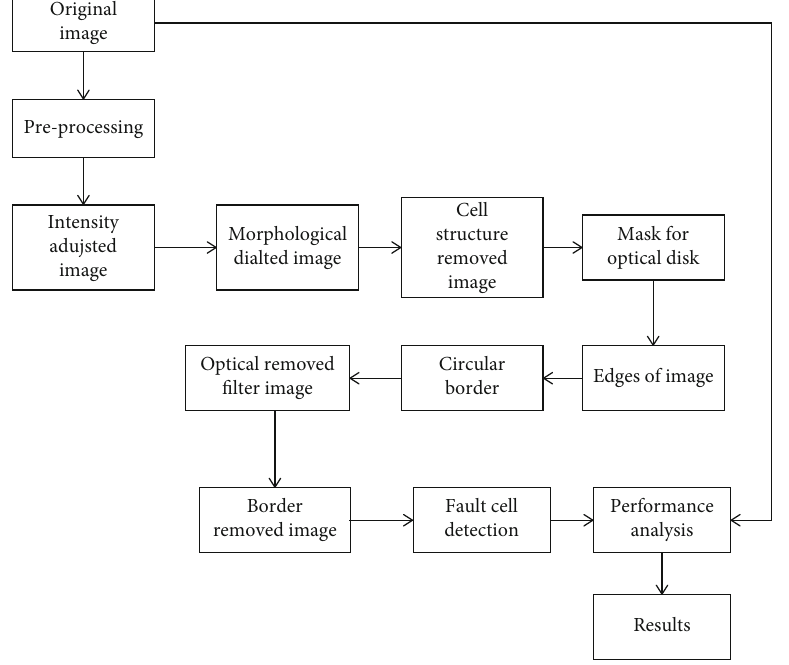
Figure 4: Flow diagram of the proposed